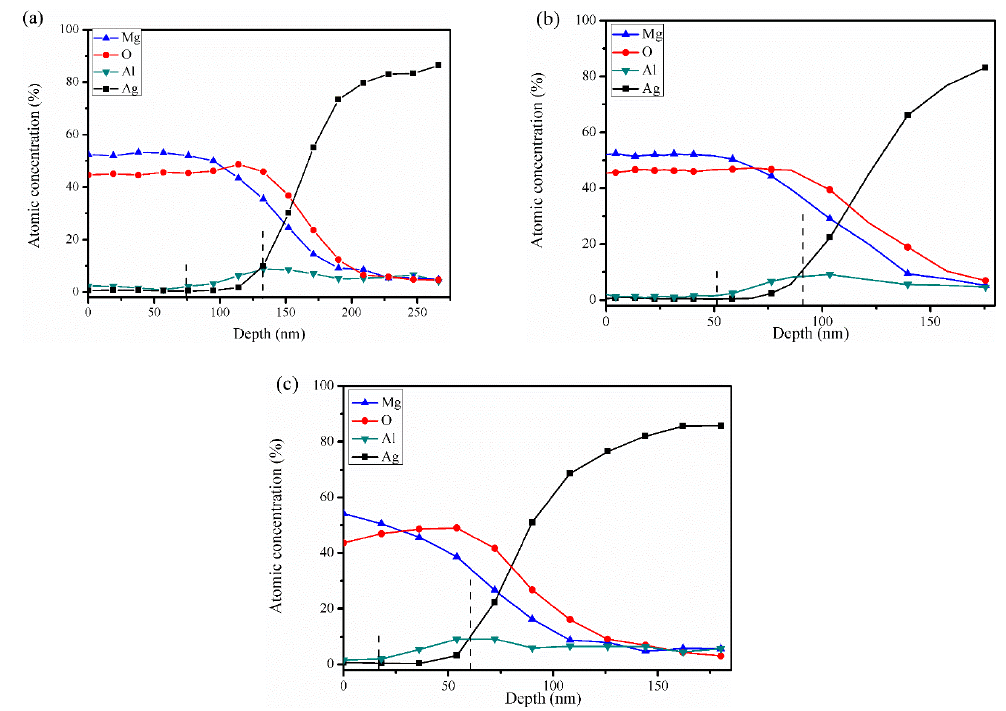
Figure 4. AES element depth profiles of the Ag-2Mg-2Al alloys activated at ( a ) 600°C for 30 min at P O 2 = 15.0 Pa; ( b ) 600 °C for 30 min at P O 2 = 20.0 Pa; and ( c ) 500 °C for 30 min at P O 2 = 20.0 Pa.